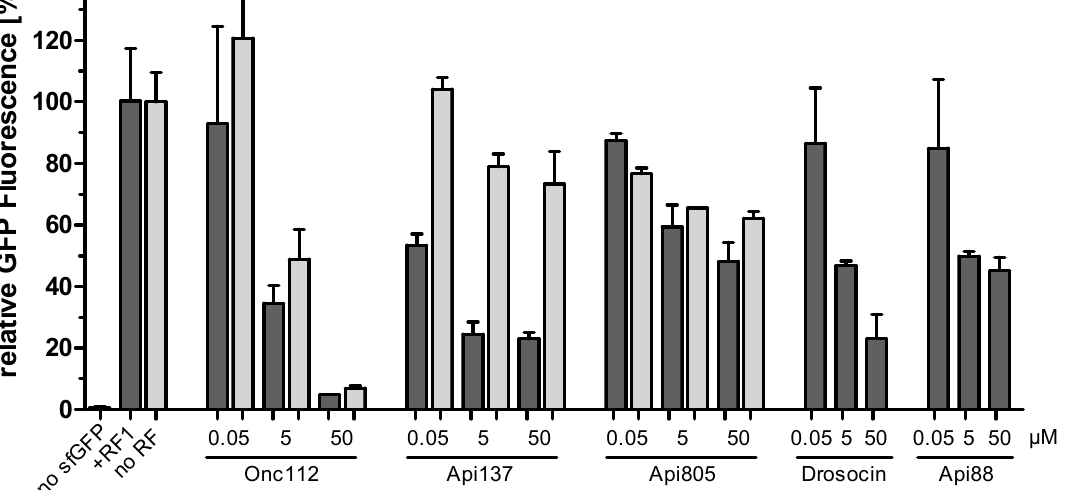
Figure 2. In vitro translation of GFP in the presence of PrAMPs Onc112, Api137, Api805, drosocin, and Api88 with (dark grey) or without (light grey) added release factor RF1. Presented is the measured GFP fluorescence relative to the control experiment without the addition of a PrAMP (=100%). Experiments were performed twice in duplicate. Error bars indicate the standard deviation of all four replicates. Significant differences were determined using t -test (Tables S4 and S5).